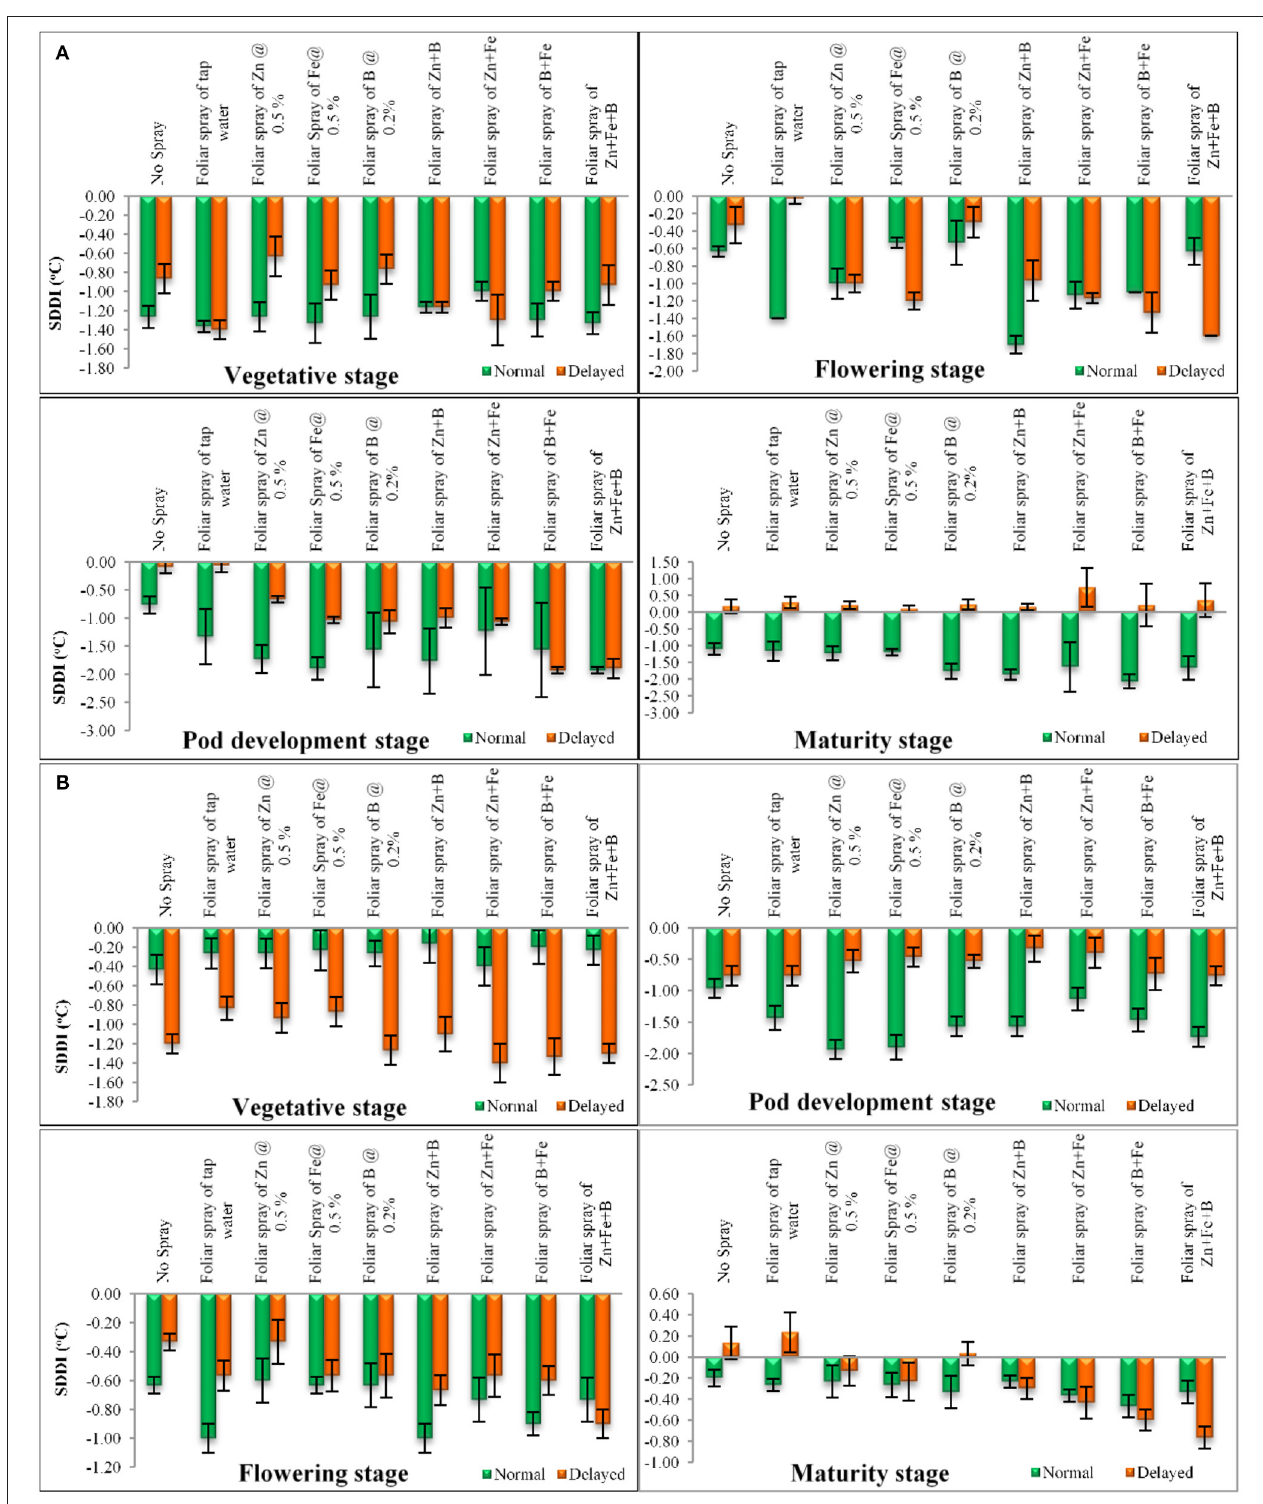
FIGURE 6 | (A) SDD index at different growth period under different dates of sowing and foliar spray (data of 2018–2019 crop season) (error bars represent the standard error of mean, and different letters indicate significant differences between means.); (B) SDD index at different growth period under different dates of sowing and foliar spray (data of 2019–2020 crop seasons) (error bars represent the standard error of mean, and different letters indicate significant differences between means).